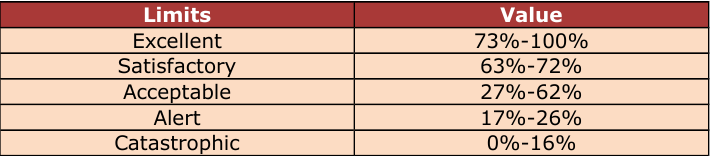
Table 7. Limit values between states in green marketing criterion